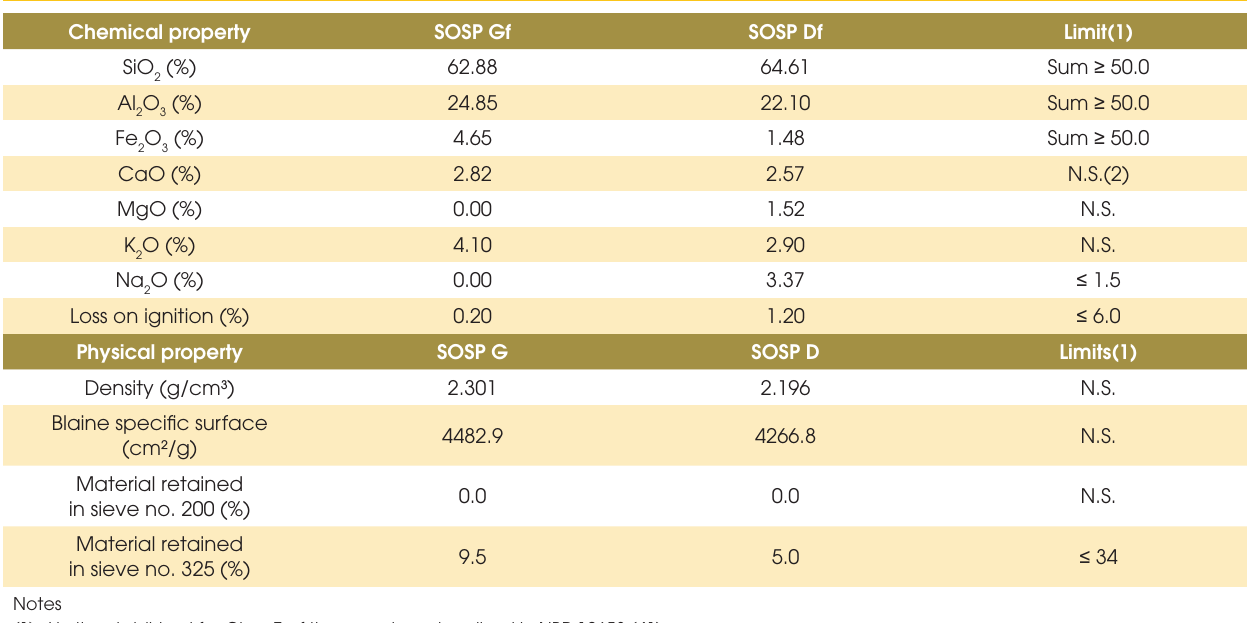
Table 5 – Chemical composition and physical properties of the wastes after TT selection Chemical